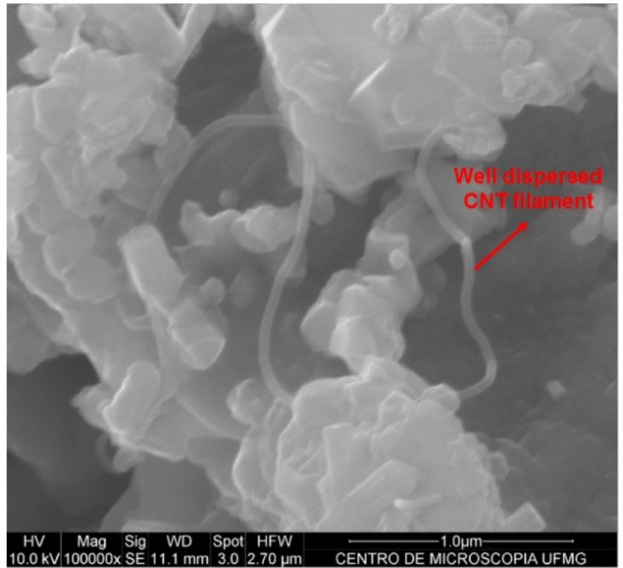
Figure 3. Scanning electron microscopy images of the anhydrous cement with 0.05% of CNTs.